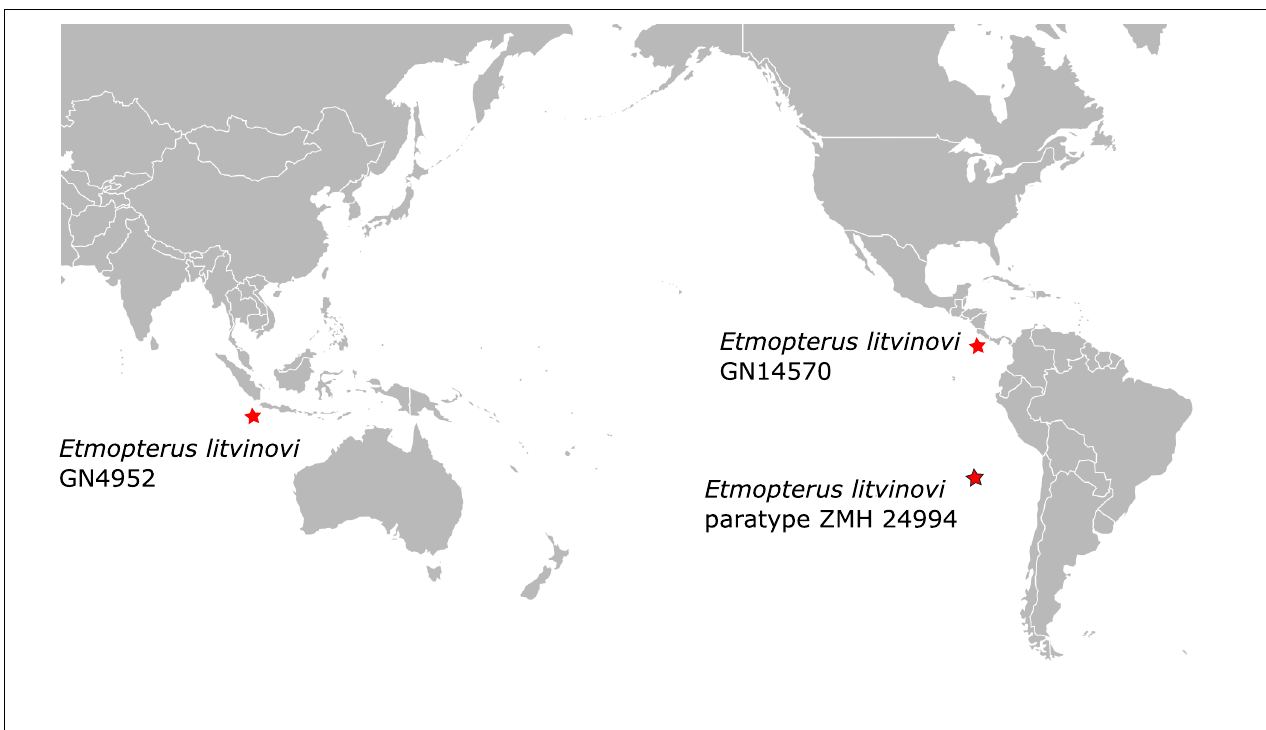
FIGURE 5 | Paratype locality of Etmopterus litvinovi ZMH 24994 (red star with black frame) and sampling locations of the two other E. litvinovi specimens (red stars) initially labeled as E. benchleyi ( Supplementary Table 1